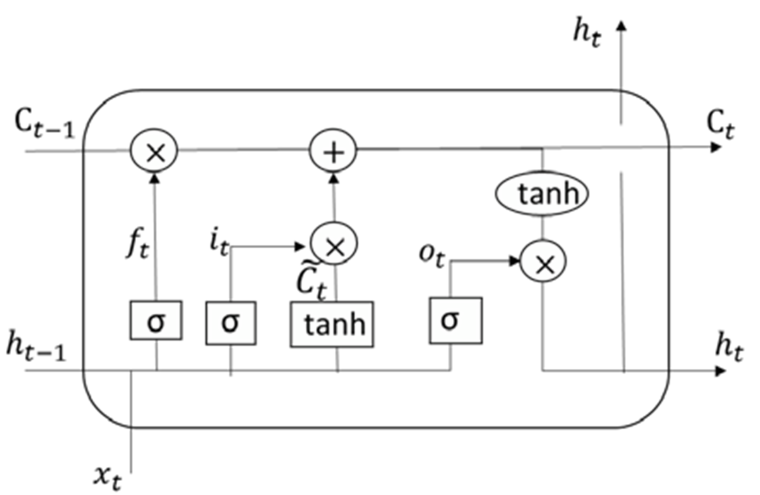
Figure 9. Representation for the Long Short Term